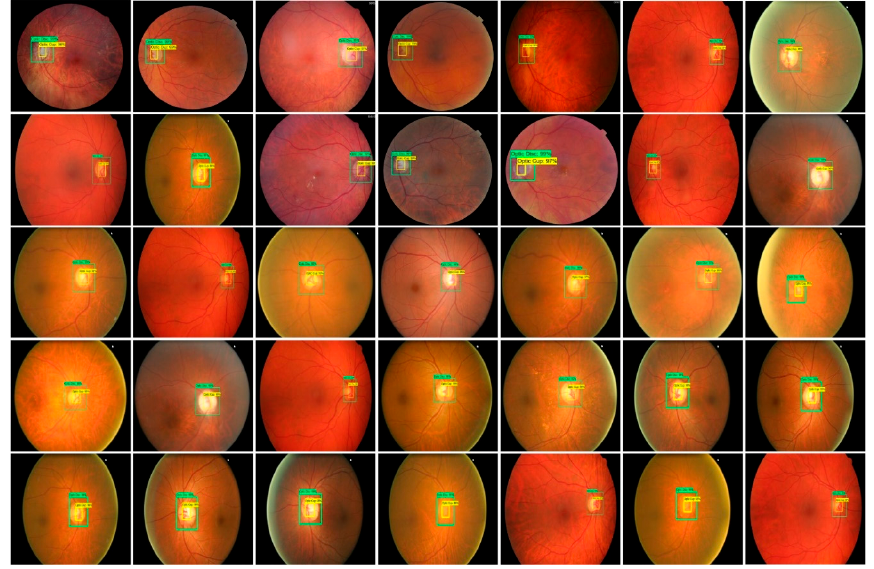
Figure 5. Localization results on test images.